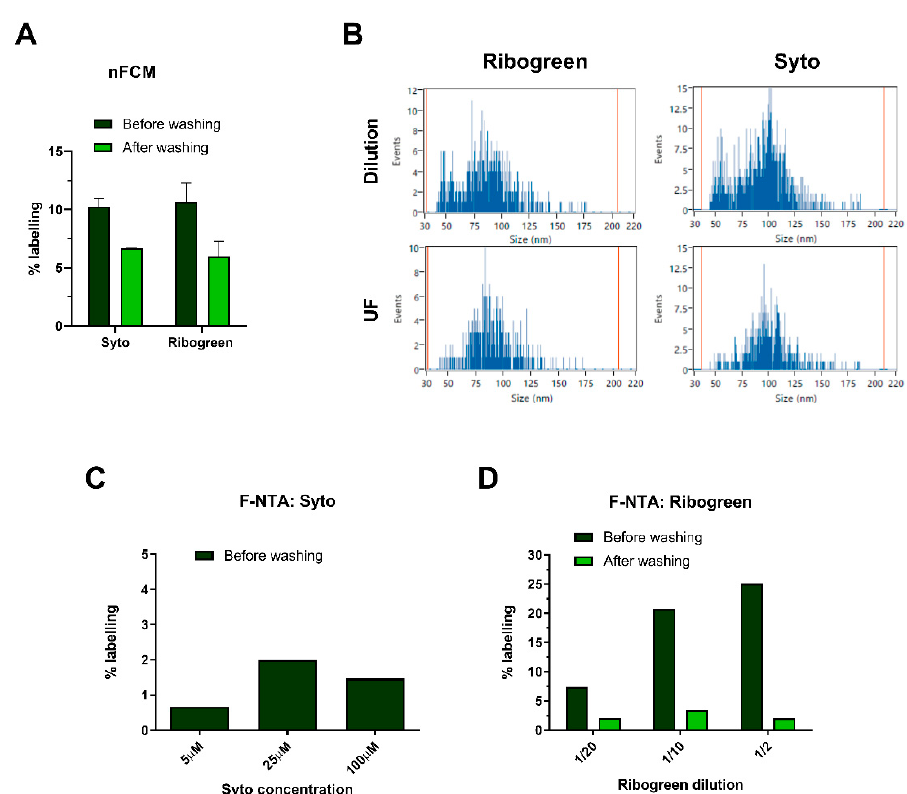
Figure 4. Identification and quantification of sEV populations based on their RNA content. ( A ) HT29 sEVs were stained with the RNA dyes Syto (25 µM) and RiboGreen (1:50). After incubation, staining reactions were washed by UF and fluorescent particles subsequently measured, with respective ( B ) PSDs analyzed on nFCM. ( C ) HT29 sEVs were incubated with Syto at increasing concentrations and the % of positive events was read on F-NTA, without applying further washing steps. ( D ) The im- pact of UF washing was evaluated on labeled HT29 sEVs, at increasing concentrations of RiboGreen. Fluorescent subpopulations were detected using F-NTA. Staining for nFCM was performed in three independent experiments ( n = 3; mean ± SEM), while for F-NTA, representative results of titration experiments are shown for both dyes. Additional data from procedural controls, as well as the F- NTA PSD histograms of analyzed samples, are provided in Supplementary Figure S3.